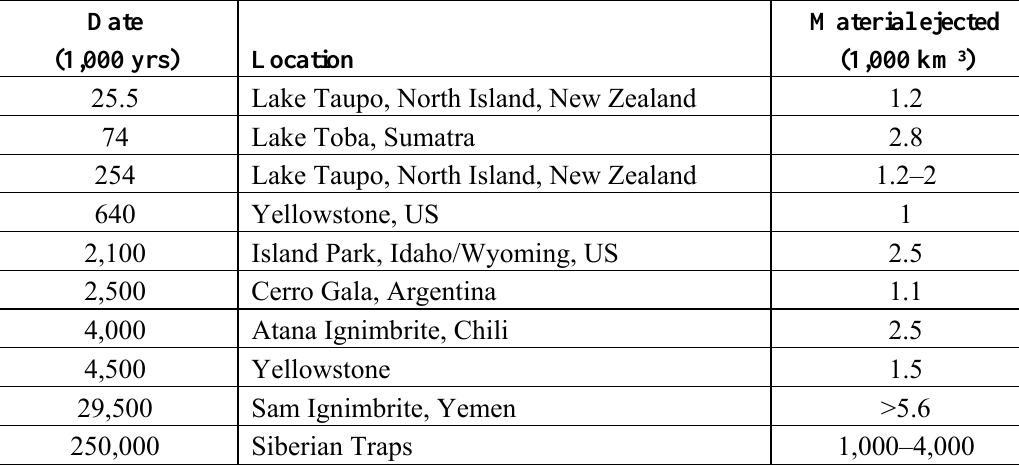
Table 1. Super volcano